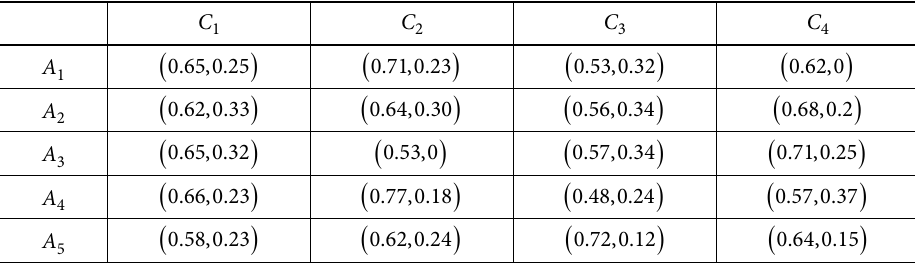
Table 7. Intuitionistic fuzzy decision matrix R  given by D C 1 C 2 C 3 C 4 A